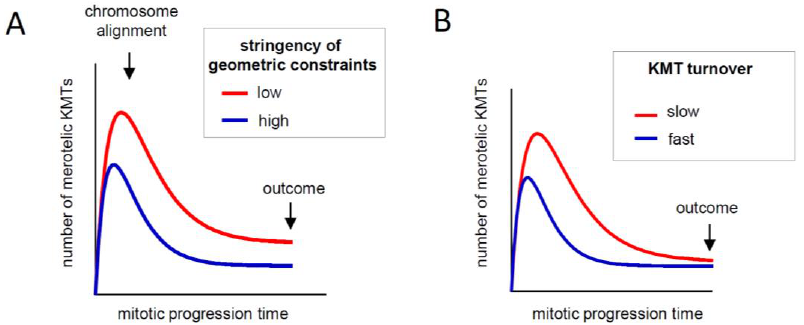
Figure 4. Quantitative analysis of the evolution of KMT configurations during mitotic progression. Graphs illustrate changes in the number of merotelic KMTs during mitotic progression, as predicted by the basic error-correction model [23]. After mitosis starts, the number of attached MTs, some of which are merotelic, increases sharply. As chromosomes become aligned midway on the spindle, the number of merotelic KMTs begins to decline. However, merotelic KMTs are not eliminated completely by this mechanism because new erroneous attachments continue to form even on congressed chromosomes, albeit at lower frequency. Thus, the system tends toward a steady state, in which the rates of forming wrong attachments and eliminating them through non-discriminatory turnover are balanced. ( A ) With more stringent geometric constraints, the final outcome for the KMT configuration at anaphase onset is improved because the rate of capturing wrong KMTs at steady-state is reduced. ( B ) The rate of KMT turnover does not affect the final outcome (black arrow). However, if anaphase starts before the steady state is reached, cells with slower KMT turnover will have more merotelic KMTs.